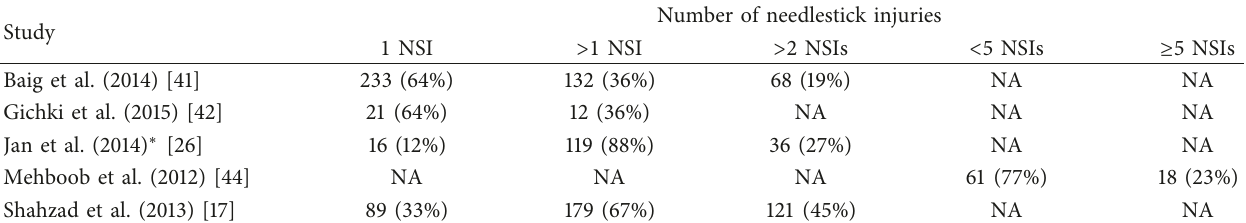
Table 2: Frequency of needlestick injuries amongst dental-HCWs who reported they had experienced at least one NSI.